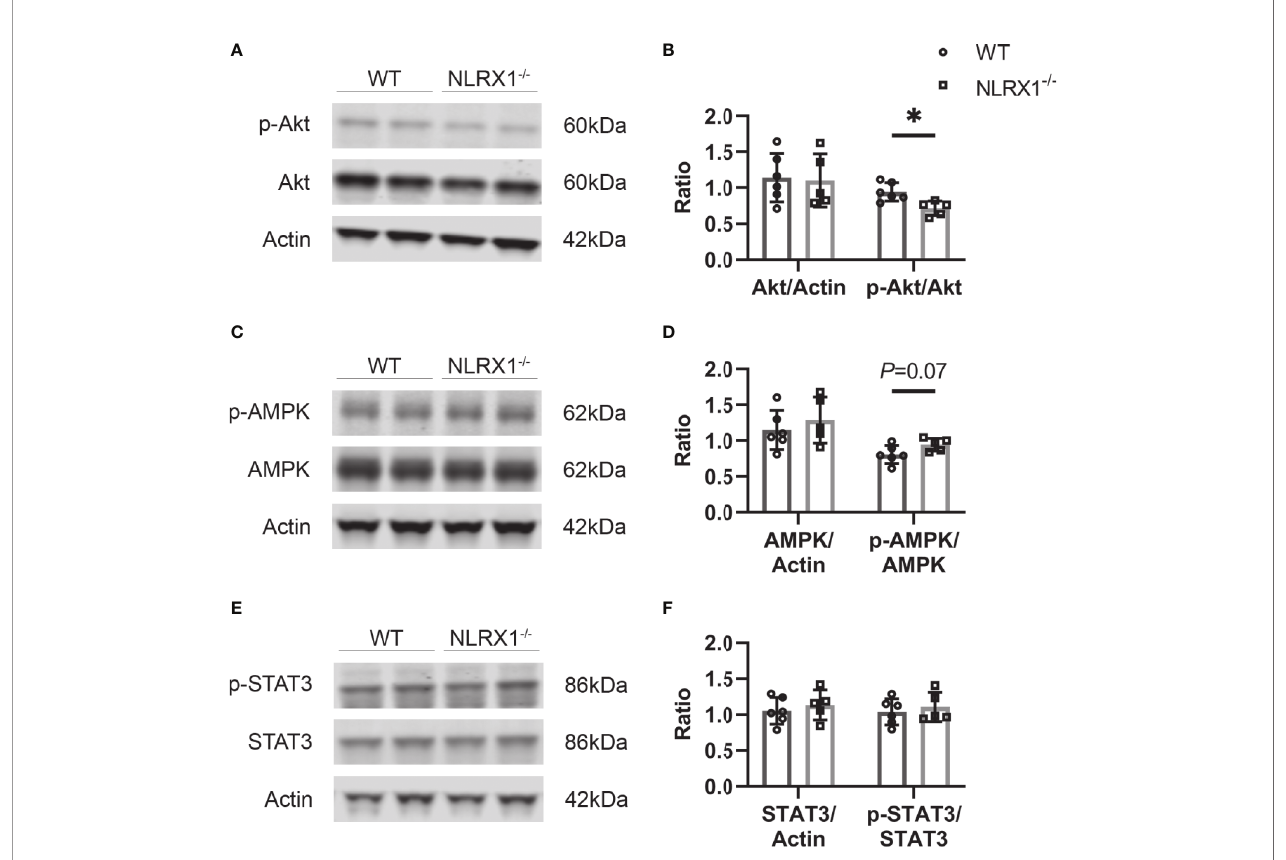
FIGURE 4 | Survival signaling pathways and in fl ammatory factors at early stage of reperfusion in severe IRI model of WT and NLRX1 -/- isolated mouse hearts of protocol 3. (A, B) Representative immunoblots and analysis of total Akt and phospho-Akt; (C, D) Representative immunoblots and analysis of total AMPK and phospho-AMPK; (E, F) Representative immunoblots and analysis of total STAT3 and phospho-STAT3. Values represent mean ± SD. (n=6/5 per group). * P < 0.05 by t